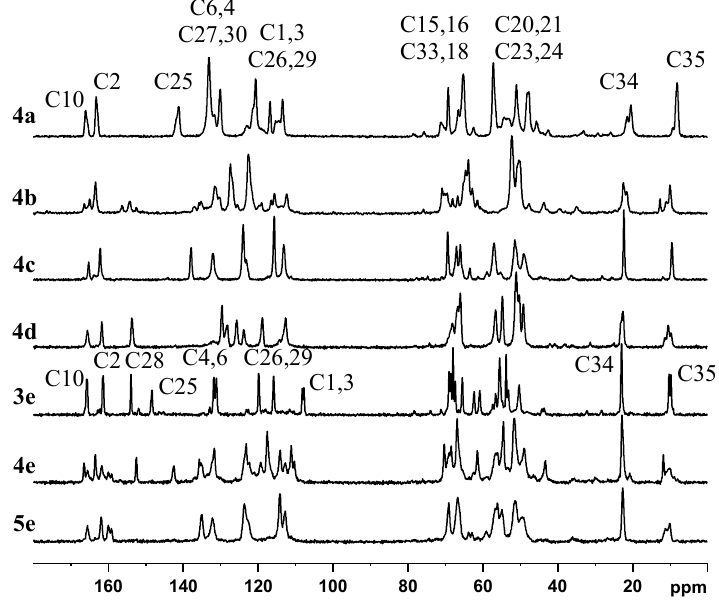
Figure 2. 13 C-CP/MAS NMR spectra of compounds 4a (R = H), 4b (R = 2-F), 4c (R = 4-F), 4d (R = 2-OCH 3 ), 3e (R = 4-OCH 3 , base), 4e (R = 4-OCH 3 , eq. HCl) and 5e (R = 4-OCH 3 , excess of HCl) together with partial illustrative signal assignment.